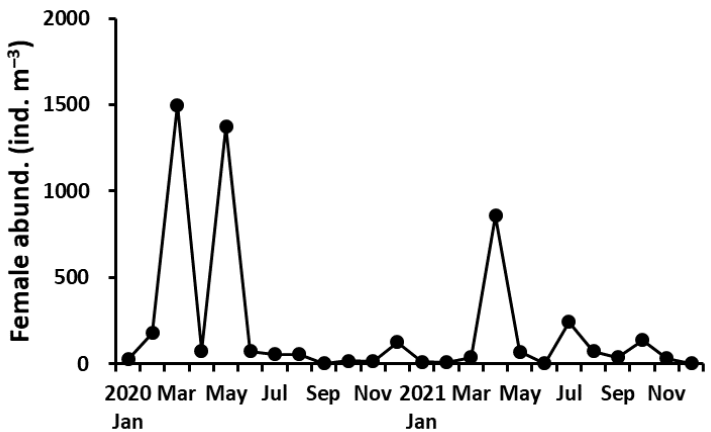
Figure 3. Variation of the abundance of adult females of P. parvus.